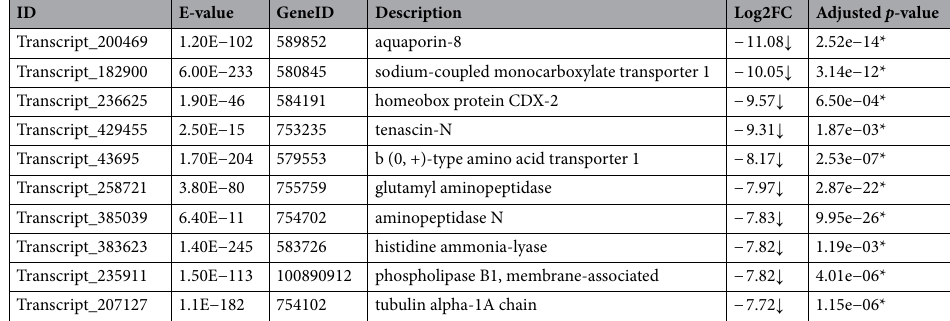
Table 4. Top 10 downregulated DEGs at day 3 of regeneration. ↓ : Downregulated (Log2FC < − 2); *: Significant ( p value < 0.01); Log2FC: Log 2 Fold